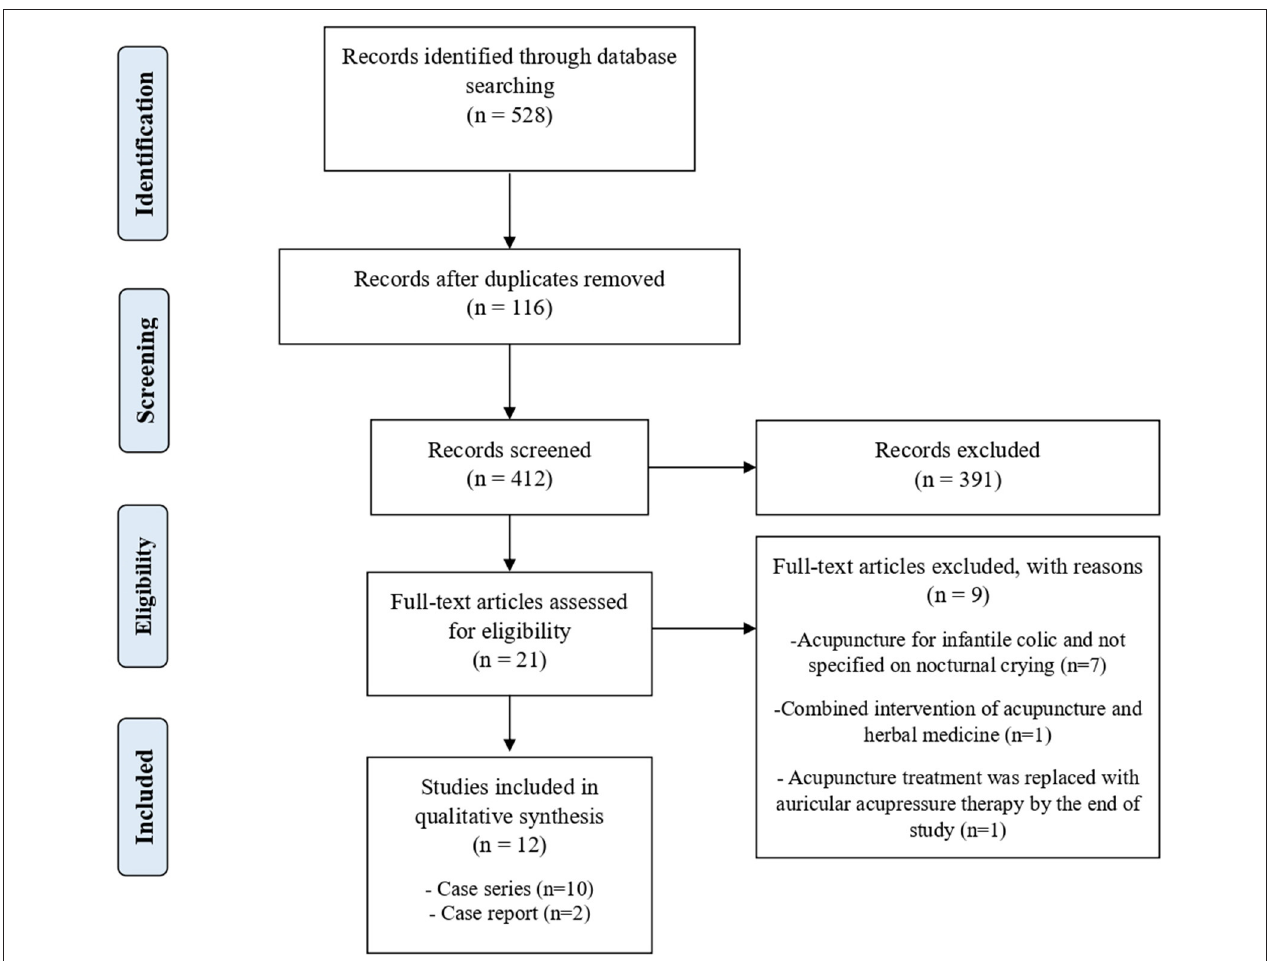
FIGURE 1 | Flow diagram of the study selection